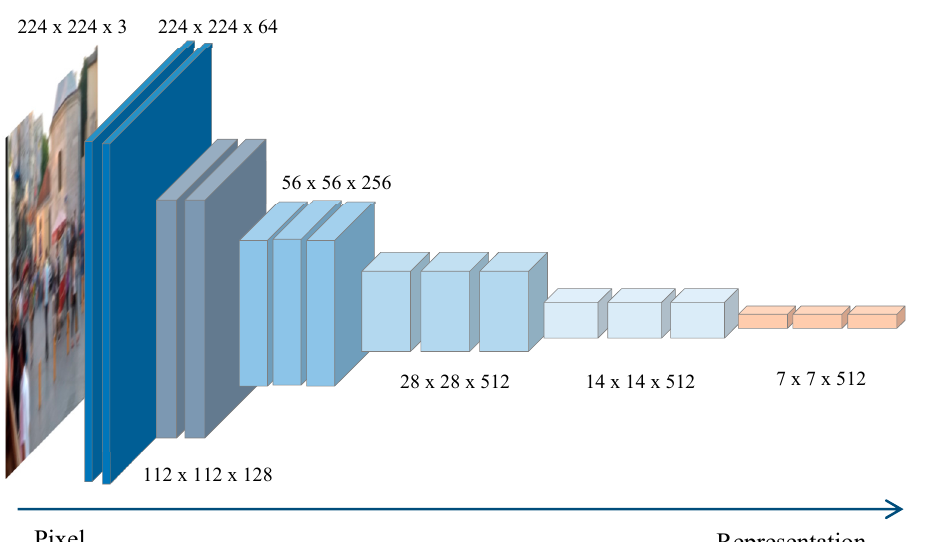
Figure 11. Generated image using low-level feature. 3.2. Total Loss Function of Network The objective of the proposed method is to generate de-blurring image from the blurred image, I (cid:2886) , by extracting the perceptual style information from the sharp image, I (cid:2903) . The network learns the similarity of the sharp image, and it reconstructs the de-blurred image from the blurred image by